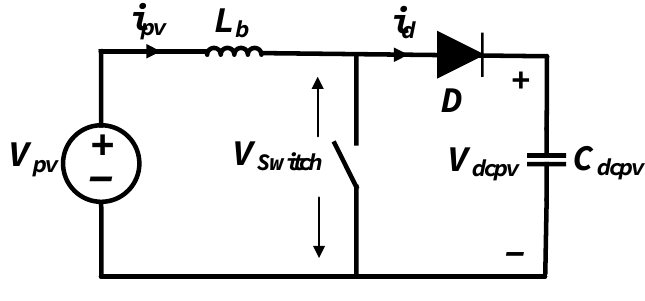
Figure 3. Simplified-photovoltaic (PV) model.